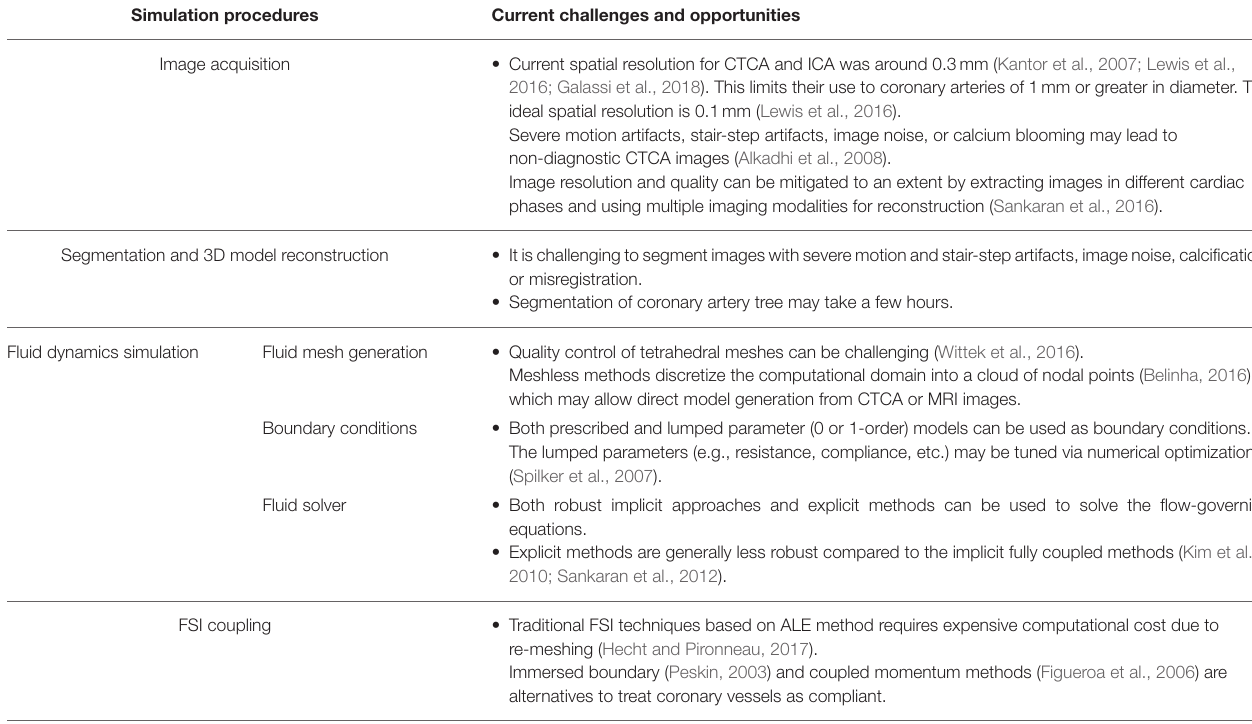
TABLE 1 | Current challenges and opportunities in numerical simulation of coronary